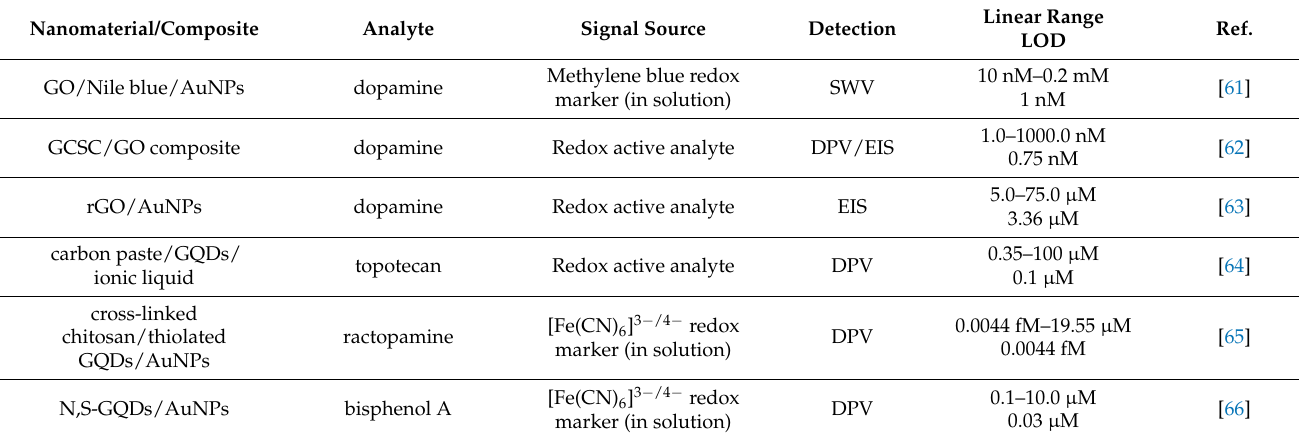
Table 2. Examples of application of carbon nanomaterials as intermediate layers.